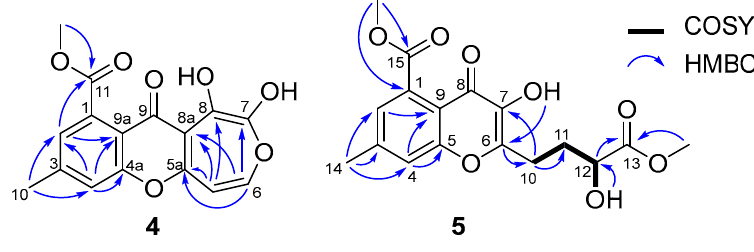
Figure 5. Key 2D-NMR correlations for 4 and 5 .